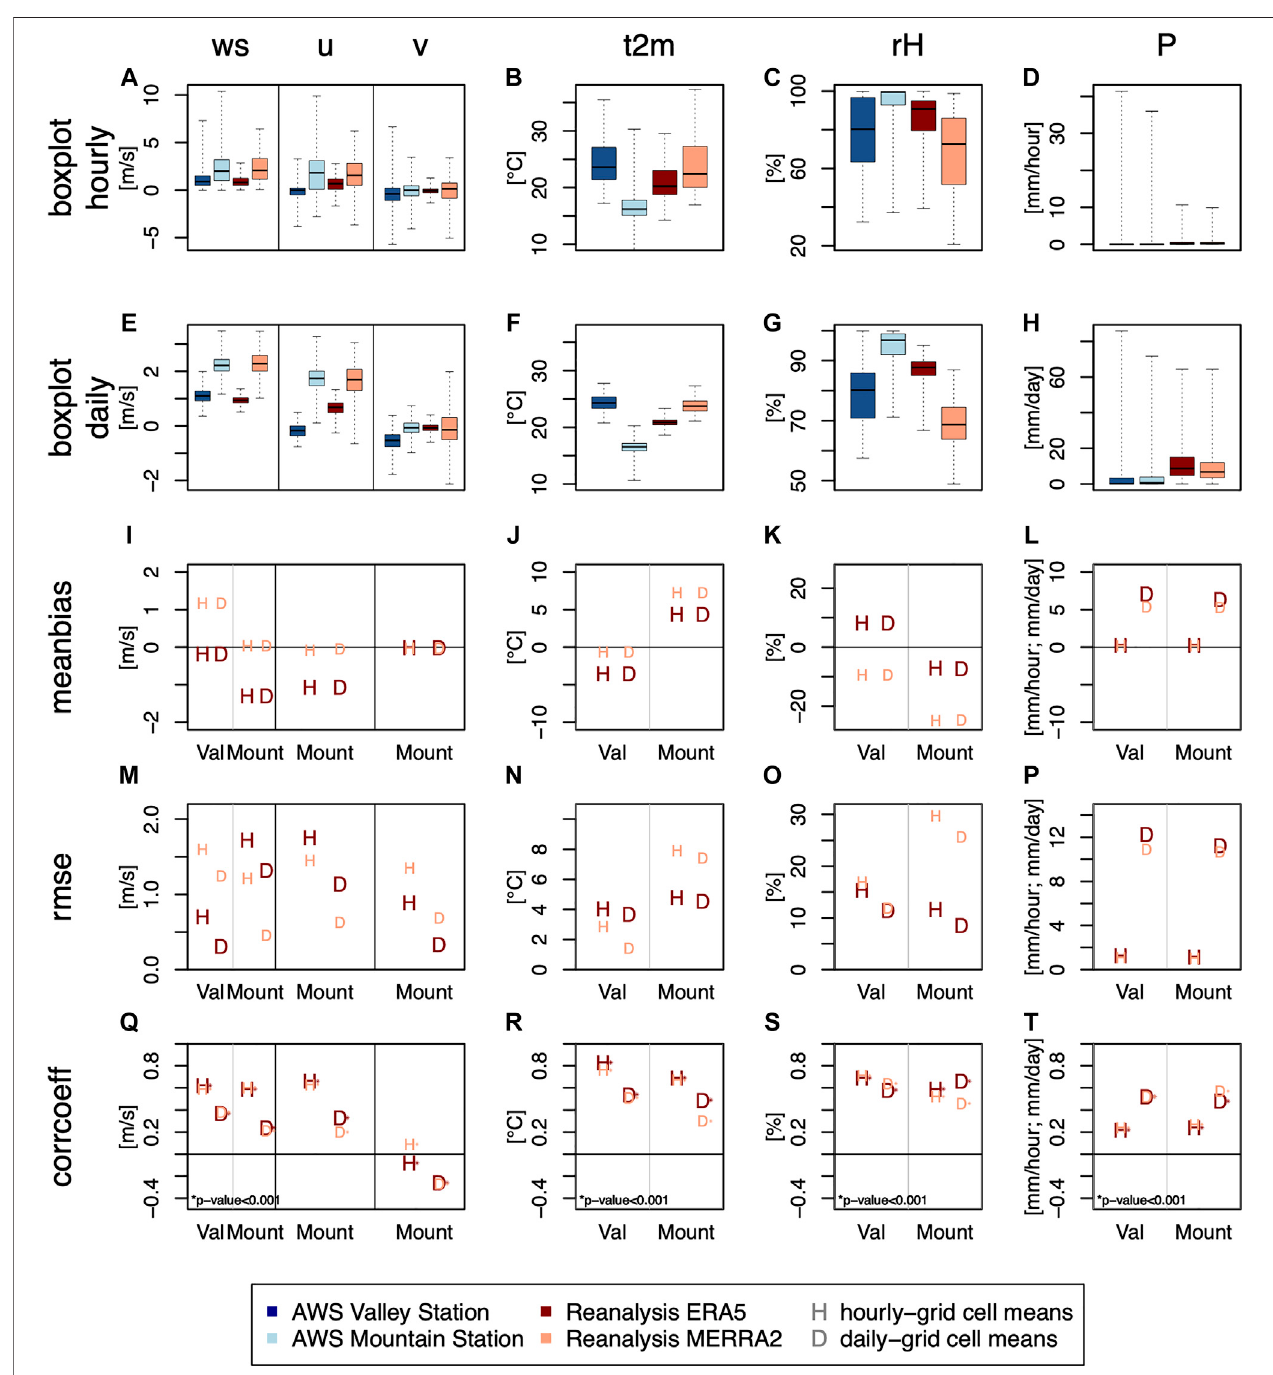
FIGURE 1 | Evaluation of ERA5 and MERRA2 against both AWS (Valley Station -Val, Mountain Station -Mount) with the consideration of their distributions (A – H) , mean bias (I – L) , rmse (M – P) , correlation coef fi cient (Q – T) for the variables wind speed (ws), u- and v-wind components, 2 m-temperature (t2m), relative humidity and total precipitation for the mean of the two closest grid cells to the study site based on hourly values and daily values.